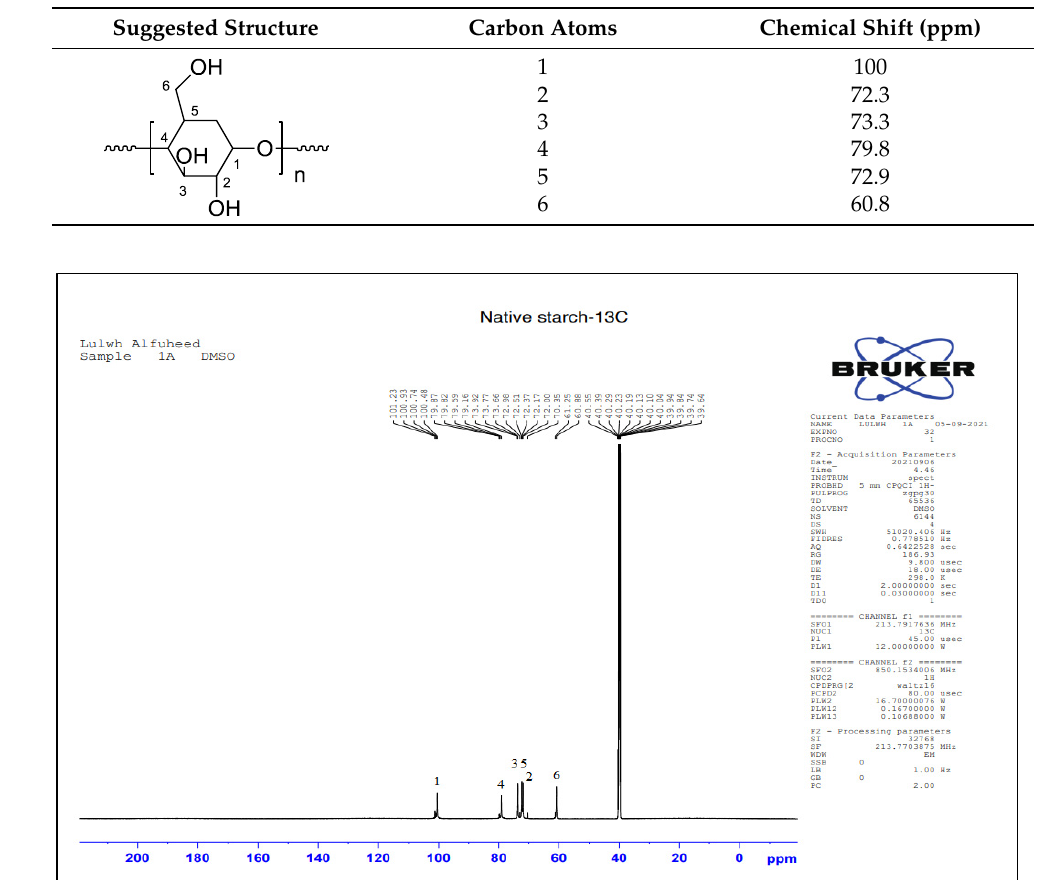
Table 2. 13 C-NMR chemical shifts of native starch.